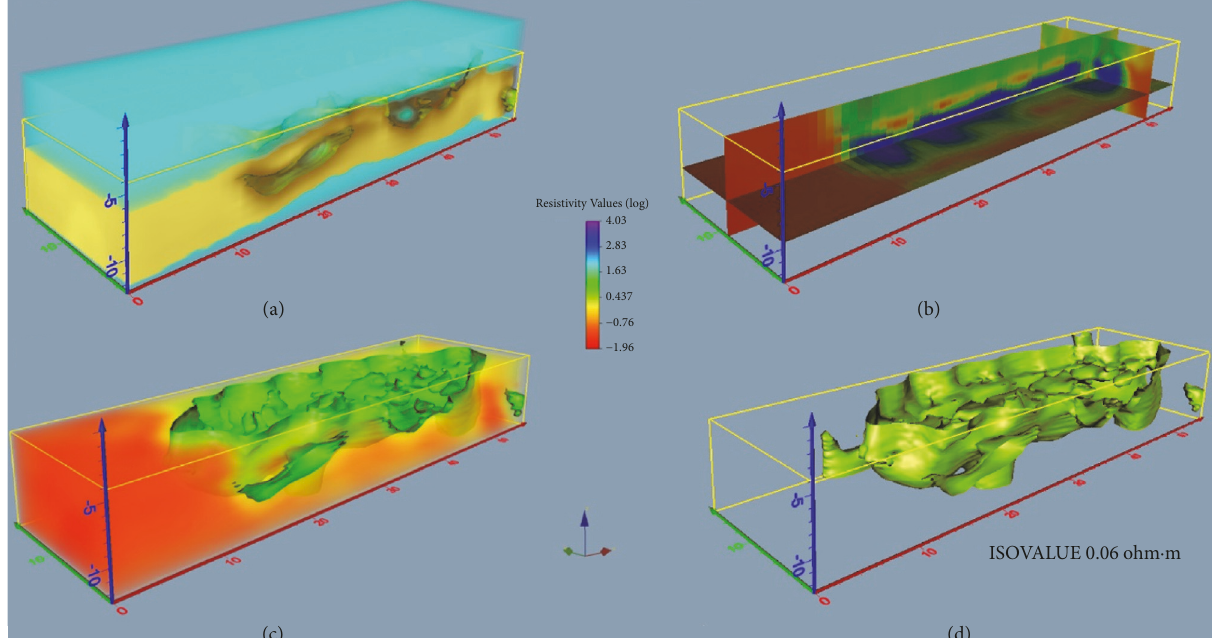
Figure 11: 3D model representation of the metallic structure of the Crowie barge. Resistivity values mapped on a logarithmic